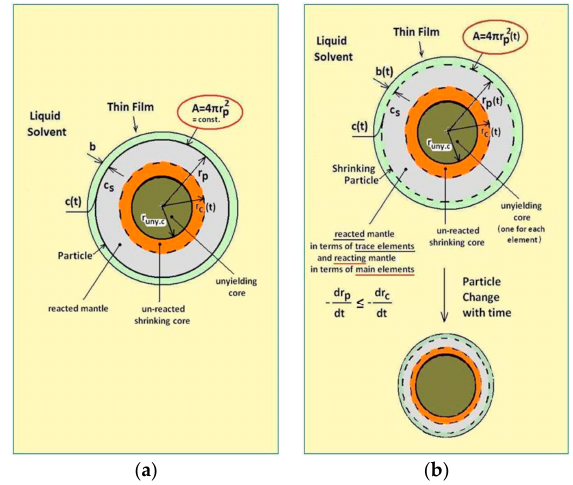
Figure 7. Visual representation of the proposed leaching model extension: ( a ) Selective to Trace Elements BR Leaching. Standard model: Thin Film Diffusion with constant particle external surface area ( A ). For very low L / S ≤ 5:1: Thin Film Diffusion is combined with the Un-Reacted Shrinking Core chemical reaction model; ( b ) Less-, or Non-, Selective to Trace Elements BR Leaching. General case: